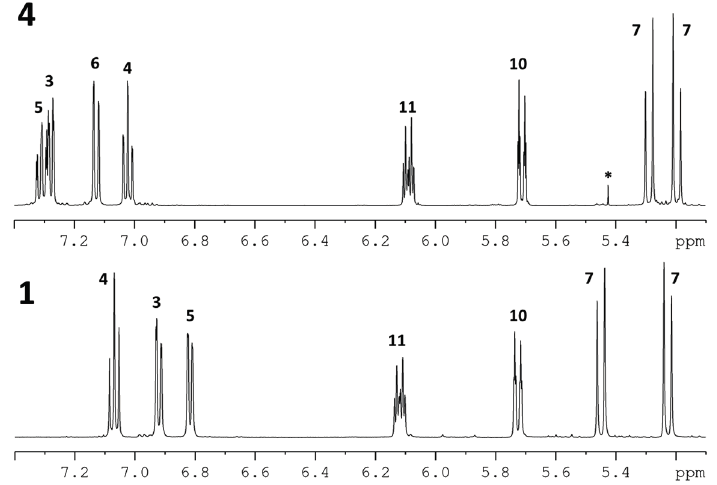
Figure 2. Partial 1 H-NMR spectra (500 MHz) of isolated salicortin ( 1 ) and idescarpin ( 4 ) in